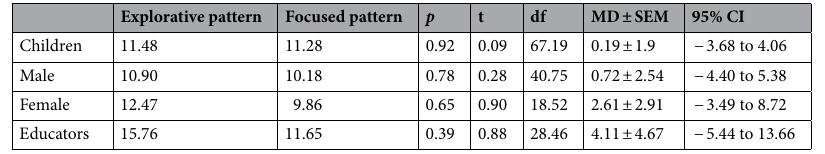
Educators. Figure 3 data-driven method showed the two eye movement patterns discovered from clustering educators’ HMMs, referred to as explorative and focused eye movement patterns. The educators who exhibited an explorative eye movement pattern (n = 20) focused on the circum-oral region, whereas the focused group (n = 14) fixated on the teeth region (Fig. 3- 1 and 2). Those who adopted the explorative pattern had a 58% probability of starting by looking in the circum-oral area of the diastema (ROI1) photo, 37% starting in the no diastema circum-oral region (ROI2), and 5% starting in the nose region (ROI3). However, fixations classified as in ROI3 were all from one participant, who may not have focused on the task. Educators’ explorative pattern was also different from children’s explorative pattern. It did not have children’s ROI1 that covered both images with its centre located between the two pictures. Educators using the focused pattern had a 48% probability of starting from viewing a broad area covering both images (ROI1), 33% probability starting from the circum-oral region of no diastema (ROI2), and 20% probability starting from the diastema (ROI3). A two-way ANOVA revealed that the two eye moment patterns were statistically significantly different ( P < 0.05). The T-test between two eye movement groups revealed sta- tistical significance in overall entropies, with the focused patterns having a higher entropy ( P < 0.05). There was no statistically significant correlation between the E–F scale and overall entropy (Pearson R = 0.19, p = 0.23). We discovered similar explorative and focused patterns to children’s data using the fixed ROI approach. For example, educators who adopted the explorative pattern (n = 22) had a 44% probability of starting in the image with no diastema (ROI1). Afterwards, they had a 45% probability of transitioning to the image with diastema (ROI2) and 55% to stay in the picture with no diastema (ROI1) (Fig. 3-3). They also had a 56% probability of starting in the image with diastema (ROI2); afterwards, they remained in the same image (56%) or transitioned to the image with no diastema (ROI1). Conversely, educators who exhibited a focused eye movement pattern (n = 12) had a 58% probability of starting in the image without diastema (ROI1). Afterwards, they had a 78% probability of staying in the same image (ROI1) and only a 22% probability of moving to the photo with diastema (ROI2). They also had a 42%